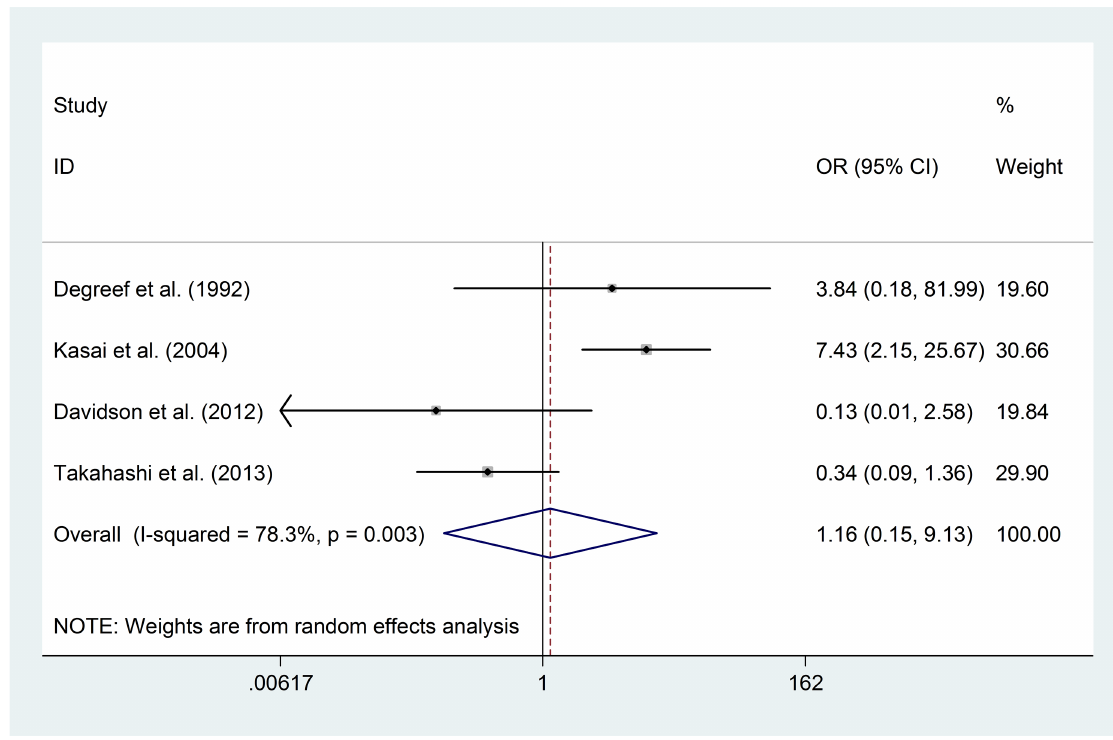
Fig 9. Prevalence of “large CSP” in FESZ patients and healthy controls.